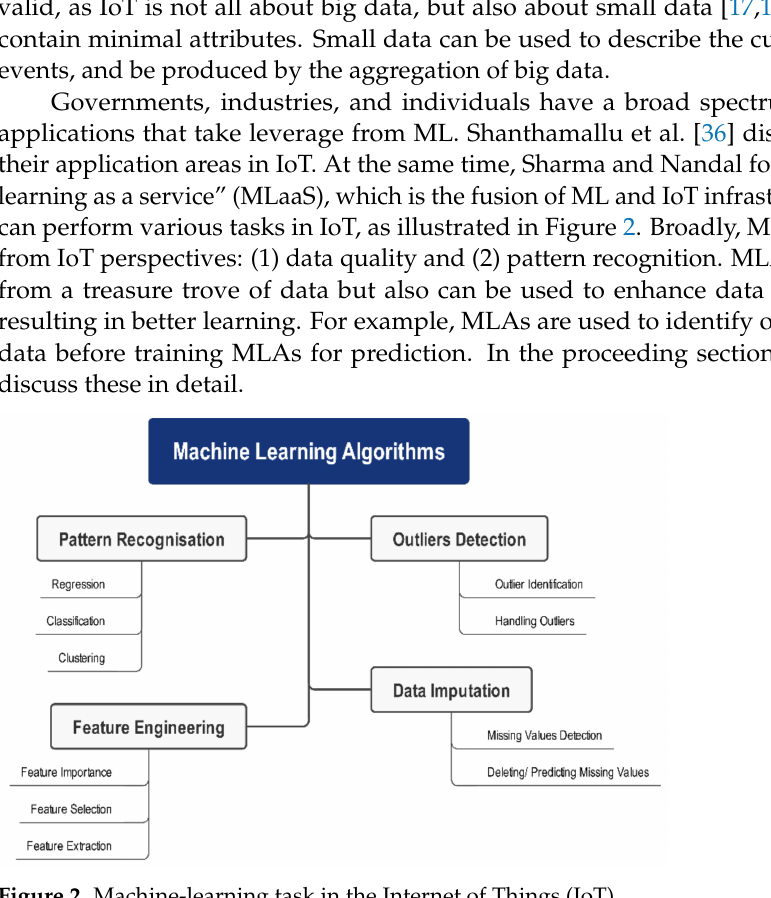
Figure 2. Machine-learning task in the Internet of Things